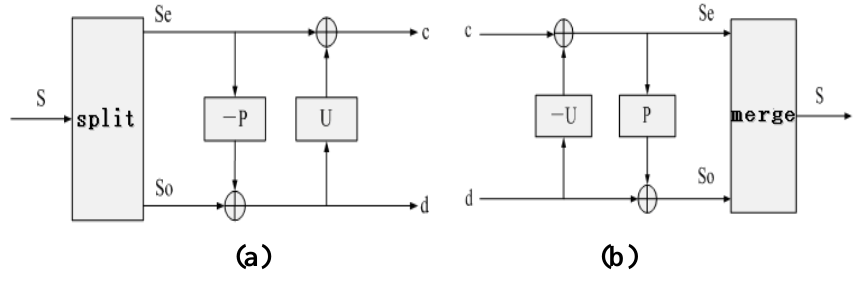
Figure 2. Decomposition and reconstruction process of the wavelet lifting. (a) decomposition of the wavelet lifting; (b) reconstruction of the wavelet